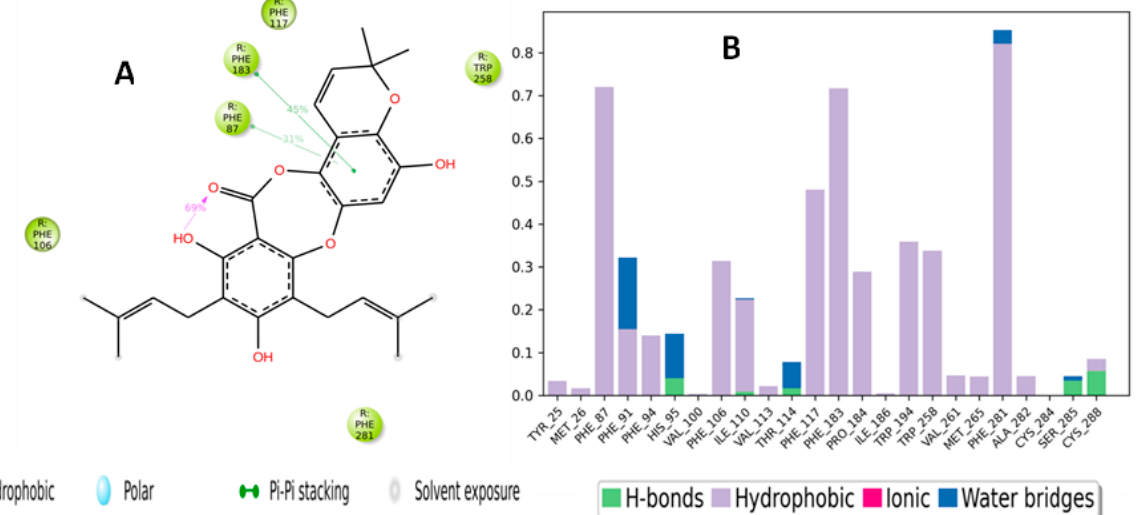
Figure 14. ( A ) Schematic detailed representation of garcinisidone E ( 215 ) interactions with the CB2 receptor (PDBID: 6KPF) residues, where blue represents the polar residues and green represents the hydrophobic residues. ( B ) Normalized stacked bar chart representing the interaction of the CB2 binding site residues with garcinisidone E ( 215 ) throughout the simulation: hydrophobic (violet), hydrogen bonds (green), and water bridges (blue). The stacked bar charts are normalized over the course of the trajectory.